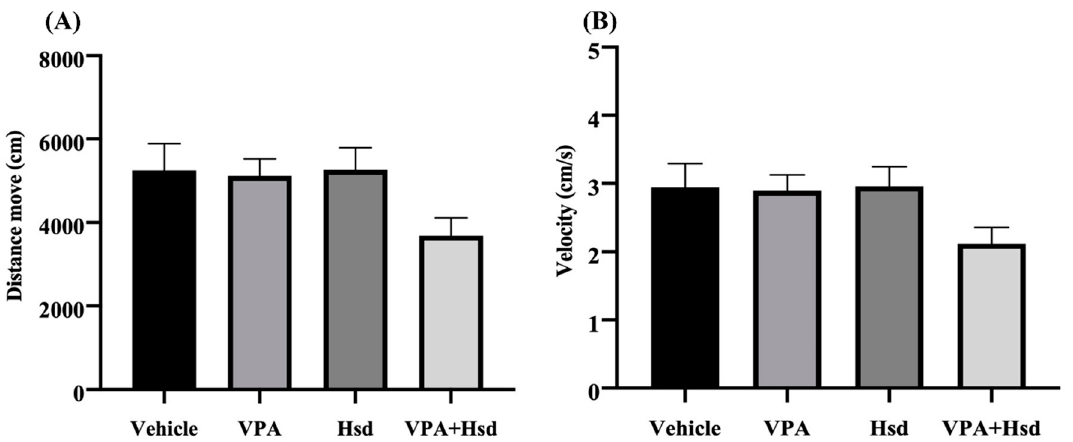
Figure 1. Locomotor activity in the novel object location test determined by the distance moved ( A ) and velocity ( B ) were significantly comparable among four groups ( p > 0.05).